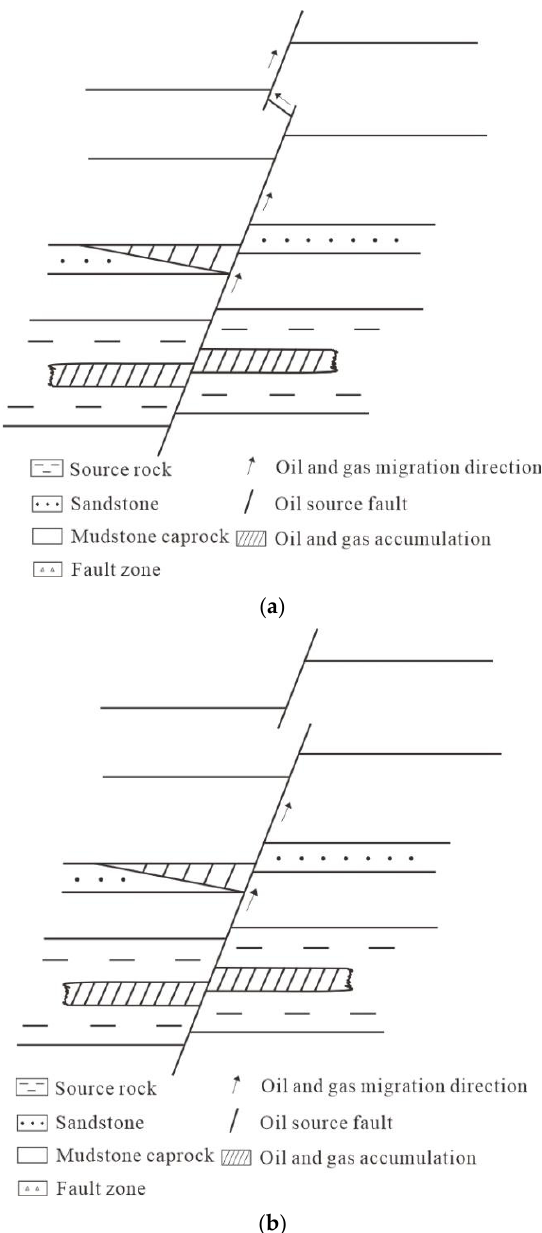
Figure 1. Schematic diagram showing mechanism of fault-shale caprock configuration leakages. ( a ) Occurrence of fault-shale caprock configuration leakage. ( b ) No occurrence of fault-shale caprock configuration leakage.